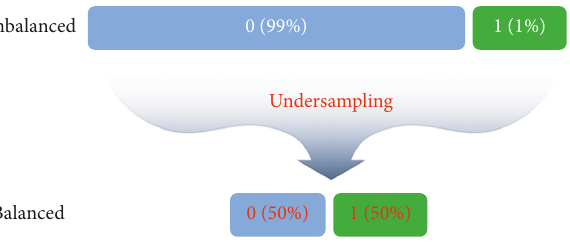
Figure 5: Undersampling